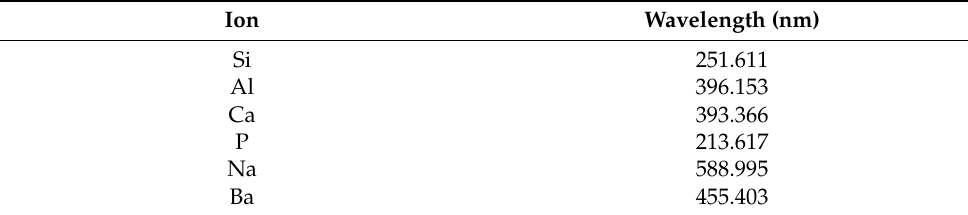
Table 9. ICP–OES emission lines selected for ions’